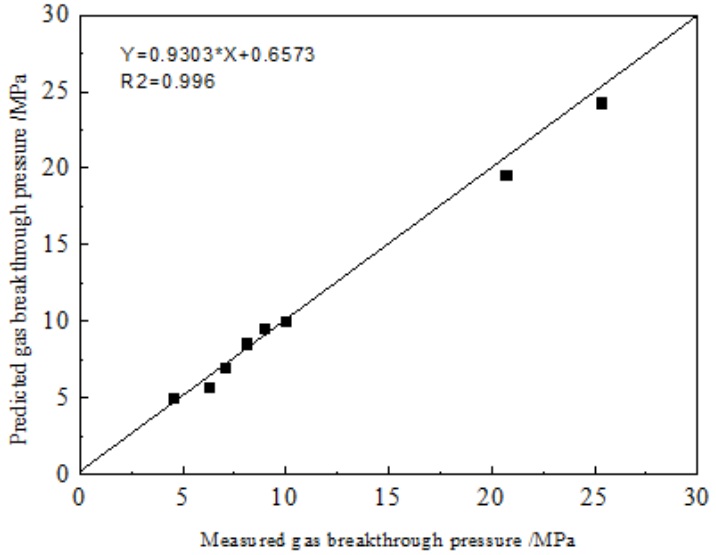
Figure 13. Linear relation between predicted gas breakthrough pressure and measured gas break- through through pressure.